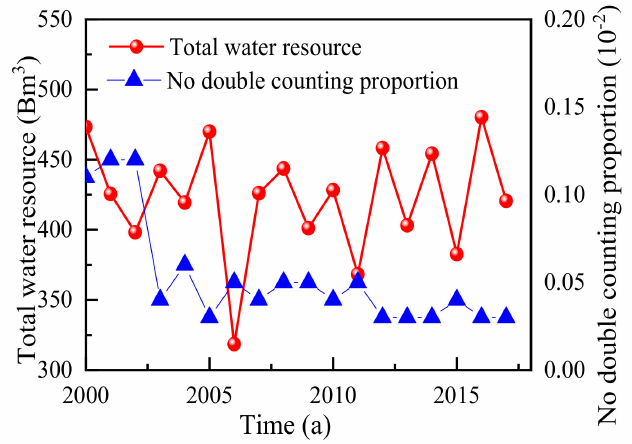
Figure 11. Historical water resource structure in upstream Yangtze River.